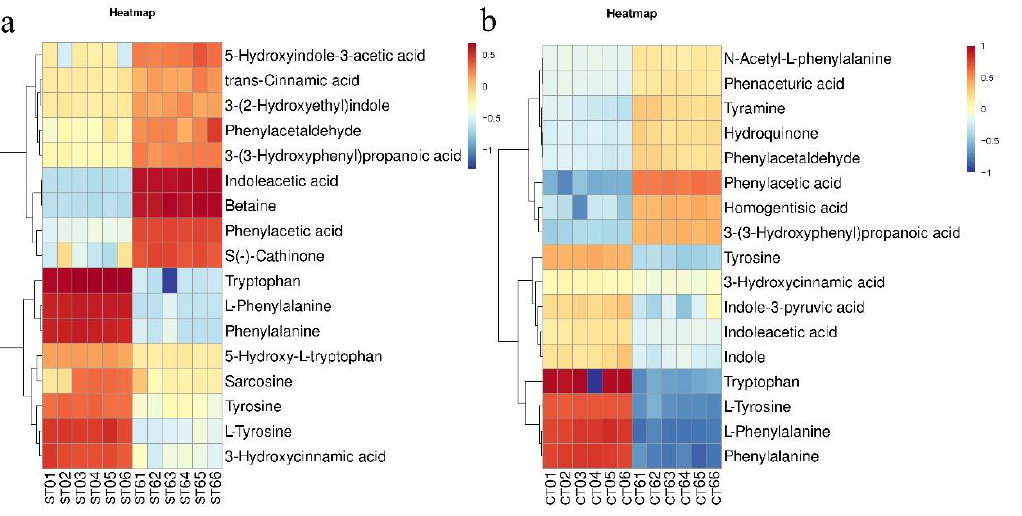
Figure 10. Analysis of different metabolites related to the amino acid metabolism pathways in the aqueous extraction group ( a ) and the alcohol extraction group ( b ) (ST — aqueous extraction group; CT — alcohol extraction group; the first number represents the fermentation day of the sample added; the second number represents the repeat group).